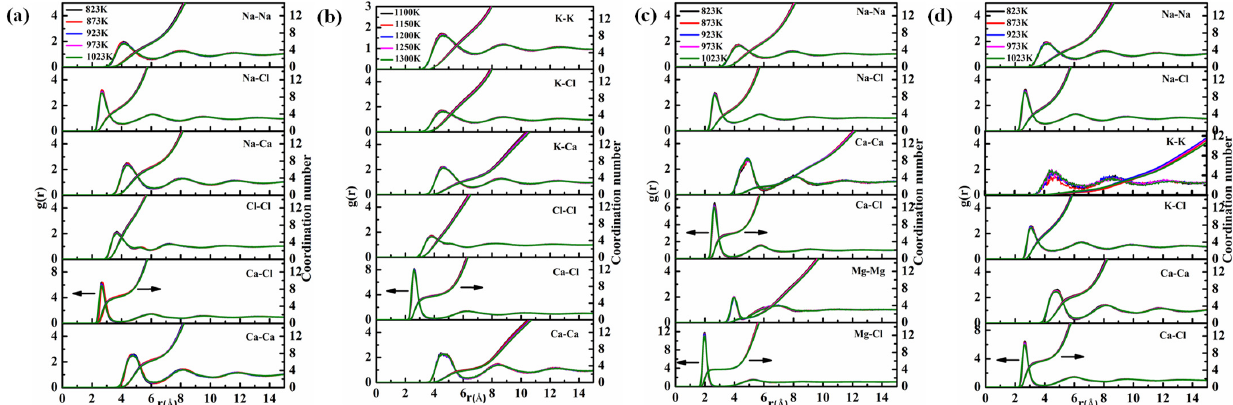
Figure 7. Radial distribution function (RDF) and coordination number curves of different chloride eutectic molten salts ( a ) NaCl ‐ CaCl 2 , ( b ) KCl ‐ CaCl 2 , ( c ) NaCl ‐ CaCl 2 ‐ MgCl 2 and ( d ) NaCl ‐ CaCl 2 ‐ KCl.